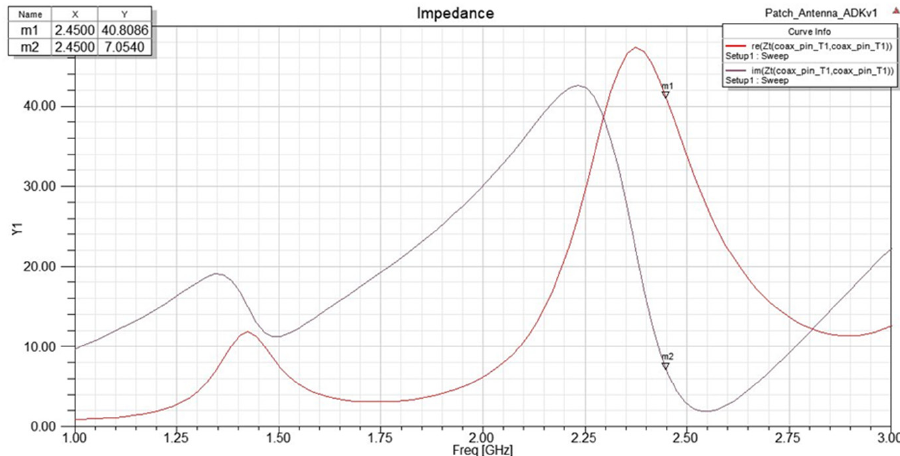
Figure 7. Calculated impedance of the antenna in the ISM band in the pancreas model.